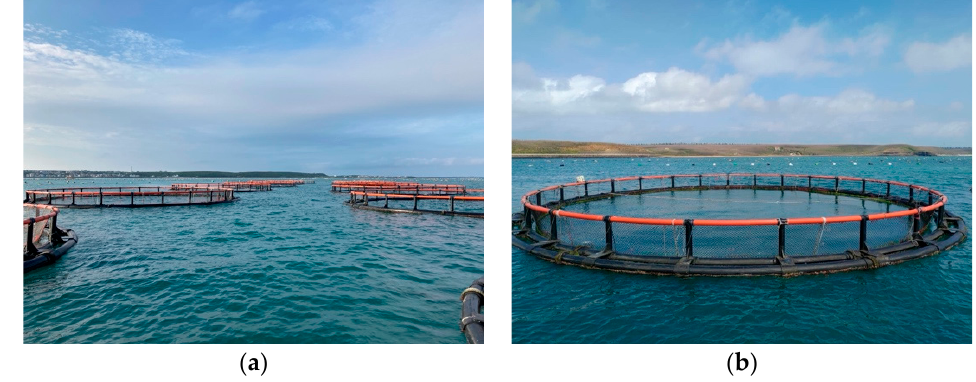
slant angle θ of 20 ◦ .